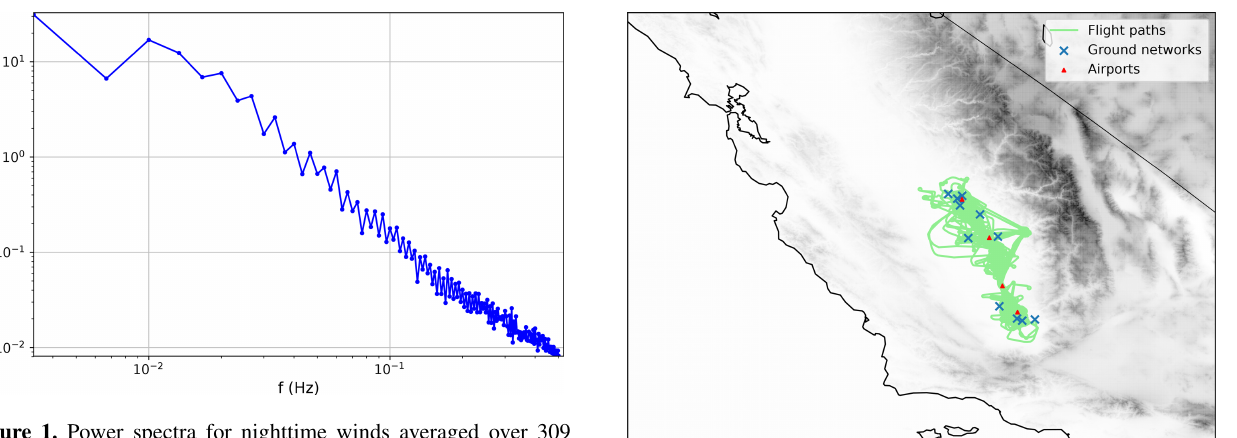
Figure 1. Power spectra for nighttime winds averaged over 309 5min samples. The average airspeed was 76.6ms − 1 .